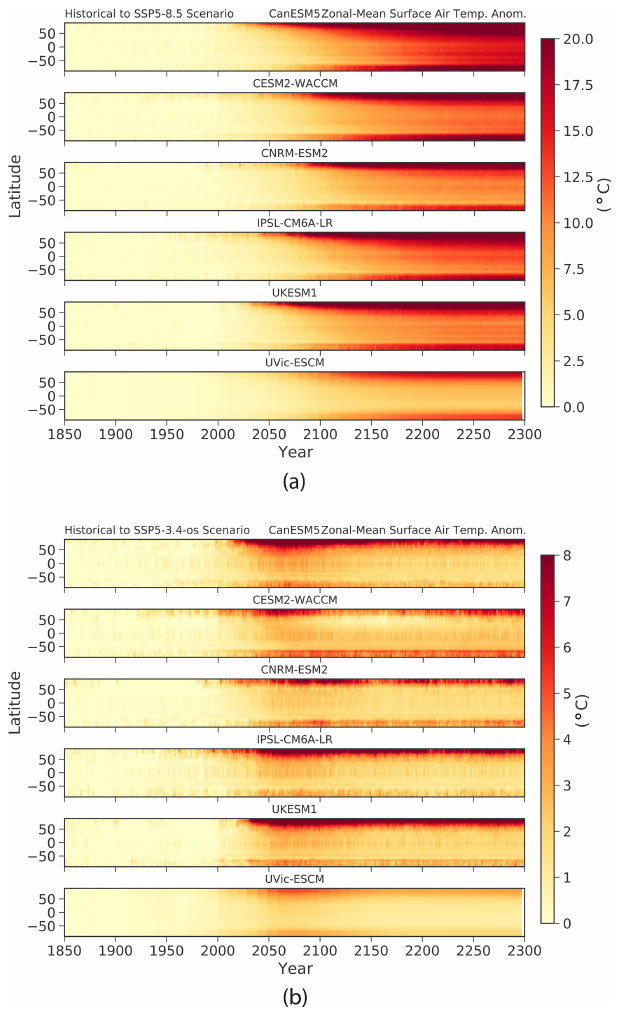
Figure 9. Zonal mean temperature anomaly dynamics of the six models under (a) the SSP5-8.5 and (b) SSP5-3.4-overshoot scenar- ios. Note the different color scales for each panel.